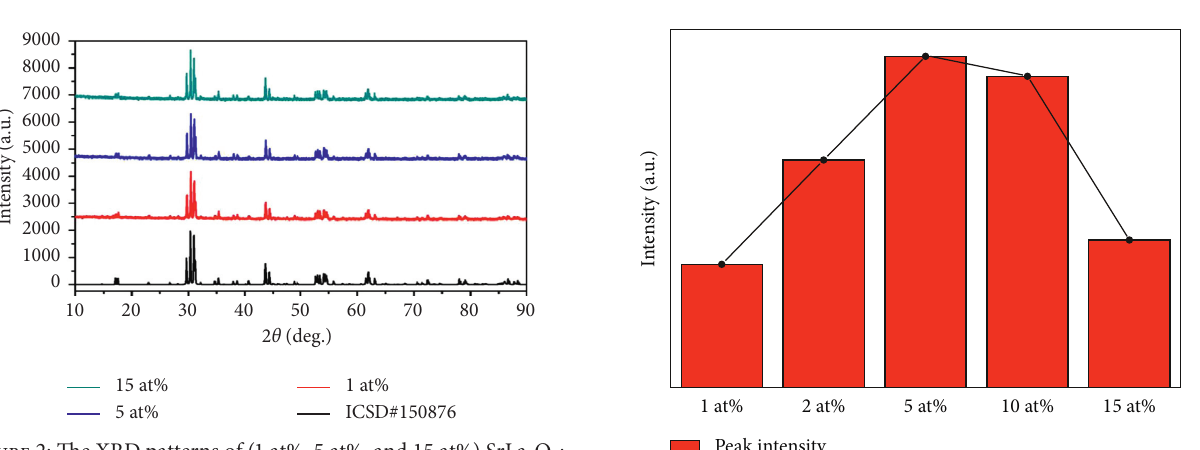
2 O 4 : phosphor with different doping concentrations.